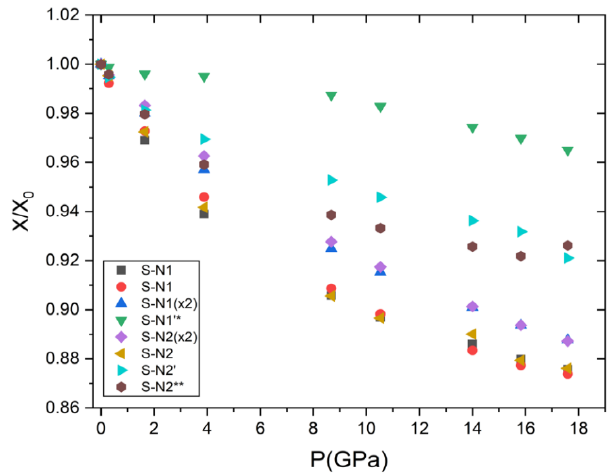
Figure 5. Evolution with pressures of sulfur-nitrogen distances. Values are given relative to their